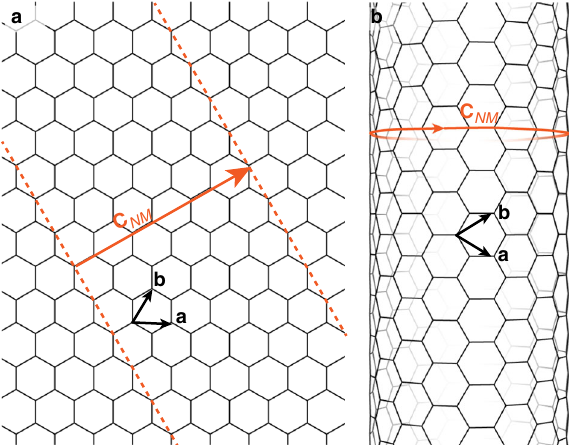
Fig. 2 Rolling up and chirality of a honeycomb sheet. a A hexagonal sheet. b An example of a nanotube obtained by cutting a ribbon perpendicularly to the chiral vector and by rolling it up. The ( N , M ) indices de fi ne the ‘ chiral vector ’ C NM ¼ N a þ M b which joins two equivalent sites, ( a , b ) being a